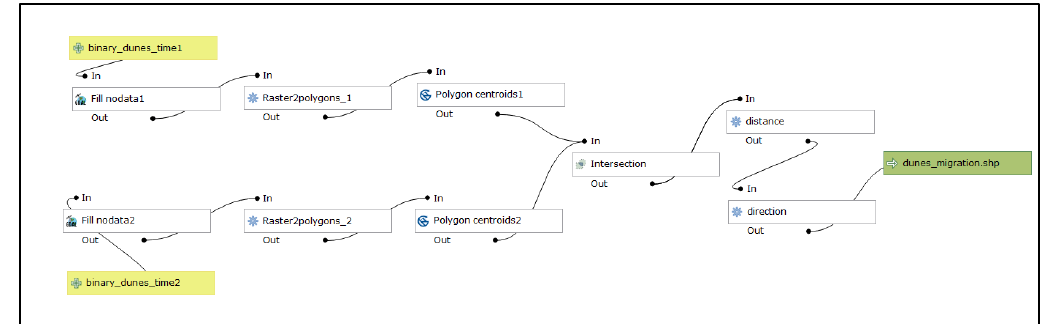
Figure 8. Processing diagram defined using the QGIS processing modeler.